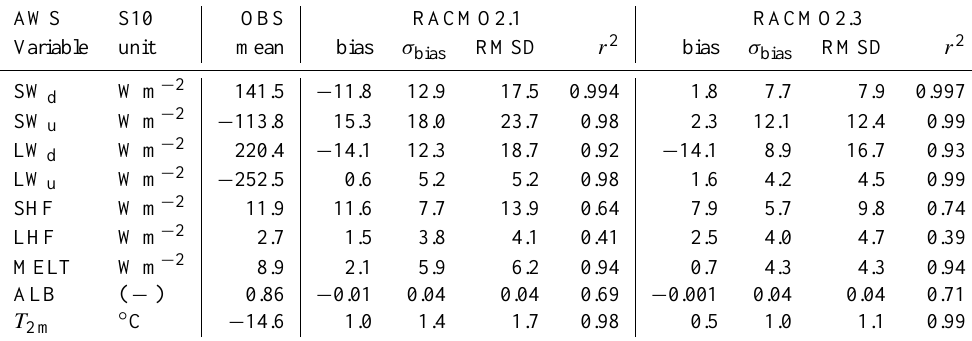
Table 3. Same as Table 1 but for station S10 (67 ◦ 00 (cid:48) N, 47 ◦ 01 (cid:48) W, 1850ma.s.l) in the accumulation zone. SEB components include annual mean data for the period